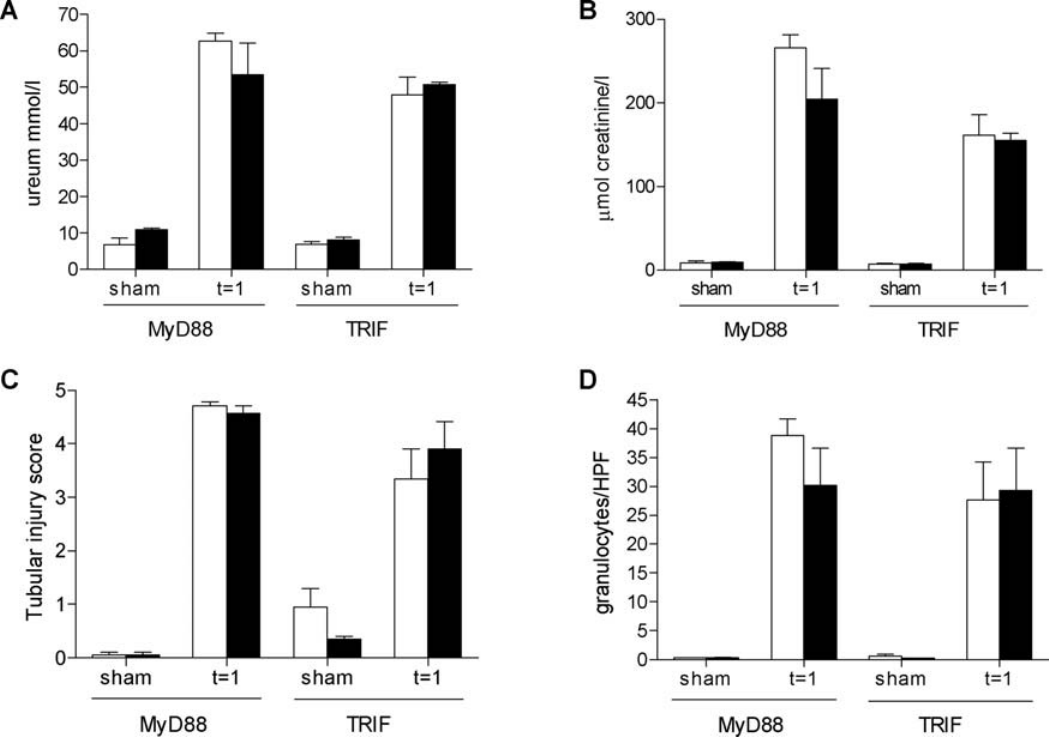
Figure 8. Renal function, injury and inflammatory influx in wild type, MyD88 2 / 2 and TRIF-mutant mice. Renal function of MyD88 2 / 2 and TRIF-mutant mice (black bars) did not differ compared with that of their wild type mice (white bars) one day after renal I/R as reflected by serum urea (A) and creatinine (B) levels and tubular injury (C). In addition, no differences were observed in the number of infiltrating granulocytes in kidneys of MyD88 2 / 2 and TRIF-mutant mice compared with their wild type mice (D). Data are mean 6 SEM of 6 (TRIF) or 8 (MyD88) mice per group (sham- operated animals: n=2/group (TRIF) or n=3/group (MyD88)). * p , 0.05.